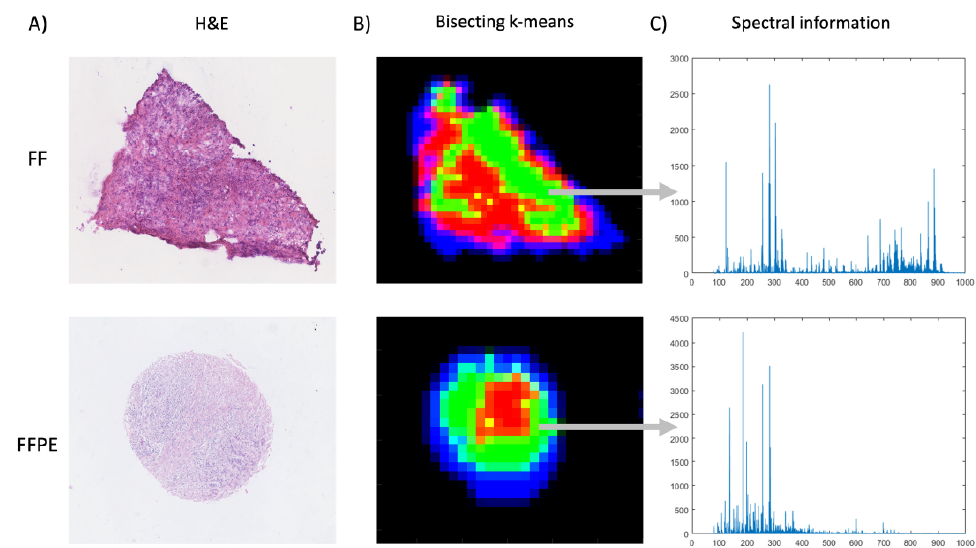
Figure 4. Spectral information comparison in FF and FFPE breast cancer tissue samples. ( A ) Corre- sponding H&E images of the FF and FFPE breast cancer tissue samples being compared. ( B ) The K-means image segmentation approach was used to visualise similar regions from the raw hyper- spectral datasets by assigning a false colour to each identified spectral cluster. Specifically, the green clusters (in both cases) are tumour regions, red clusters are tumour stroma, blue clusters are the tissue background, and black clusters are the slide background. ( C ) Spectral information (50–1000 m / z ) illustrated by the mean spectra extracted from breast tumour regions (green) of FF and FFPE tissue samples. The spectral intensities are raw unnormalised counts.